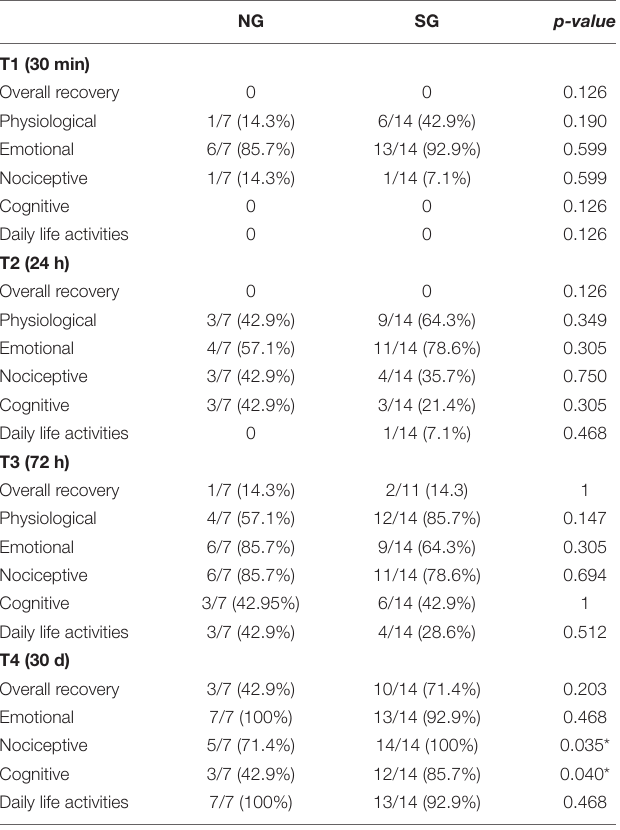
TABLE 4 | Percentages of patients in the different items of the cognitive domain at TABLE 3 | Overall recovery rates and recovery rates by domains in the PQRS at different time points. different time points. NG SG p-value Cognitive domain NG SG p- value